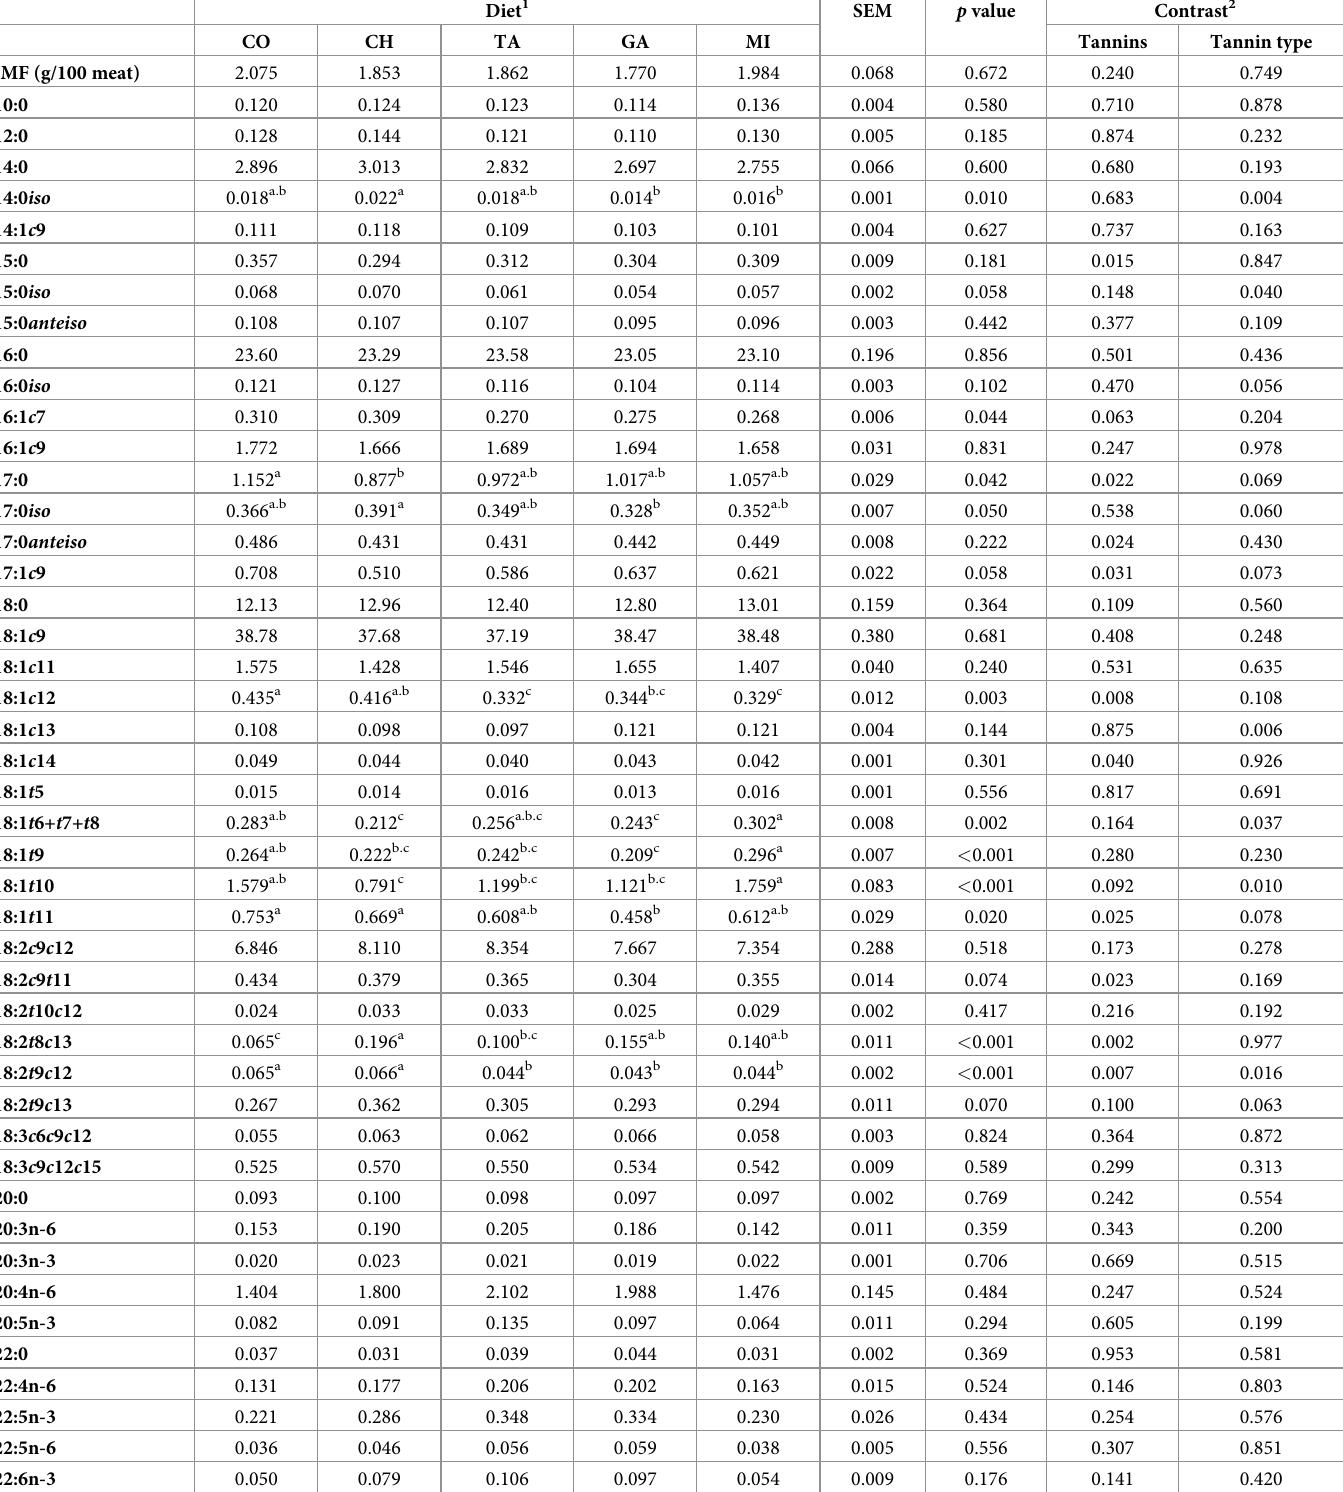
Table 5. Effect of different tannin extracts on meat fatty acid composition (g/100g total fatty acids). Diet 1 SEM p value Contrast